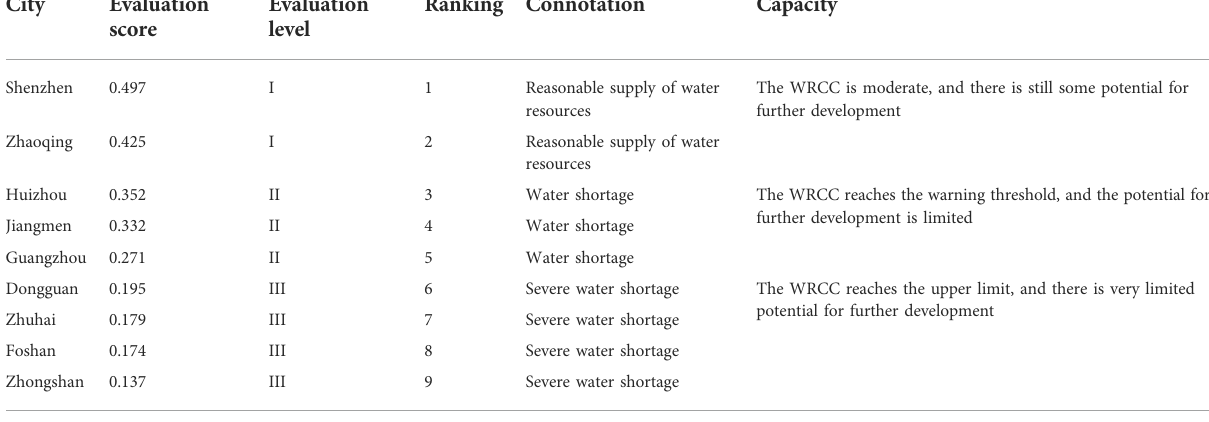
TABLE 3 Mean WRCC of cities in the PRD from 2015 to 2020. City